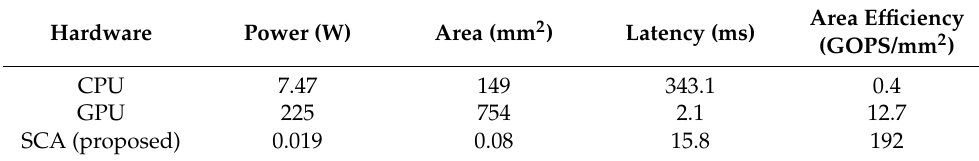
Table 1. Comparison with Conventional Logic-based Computing